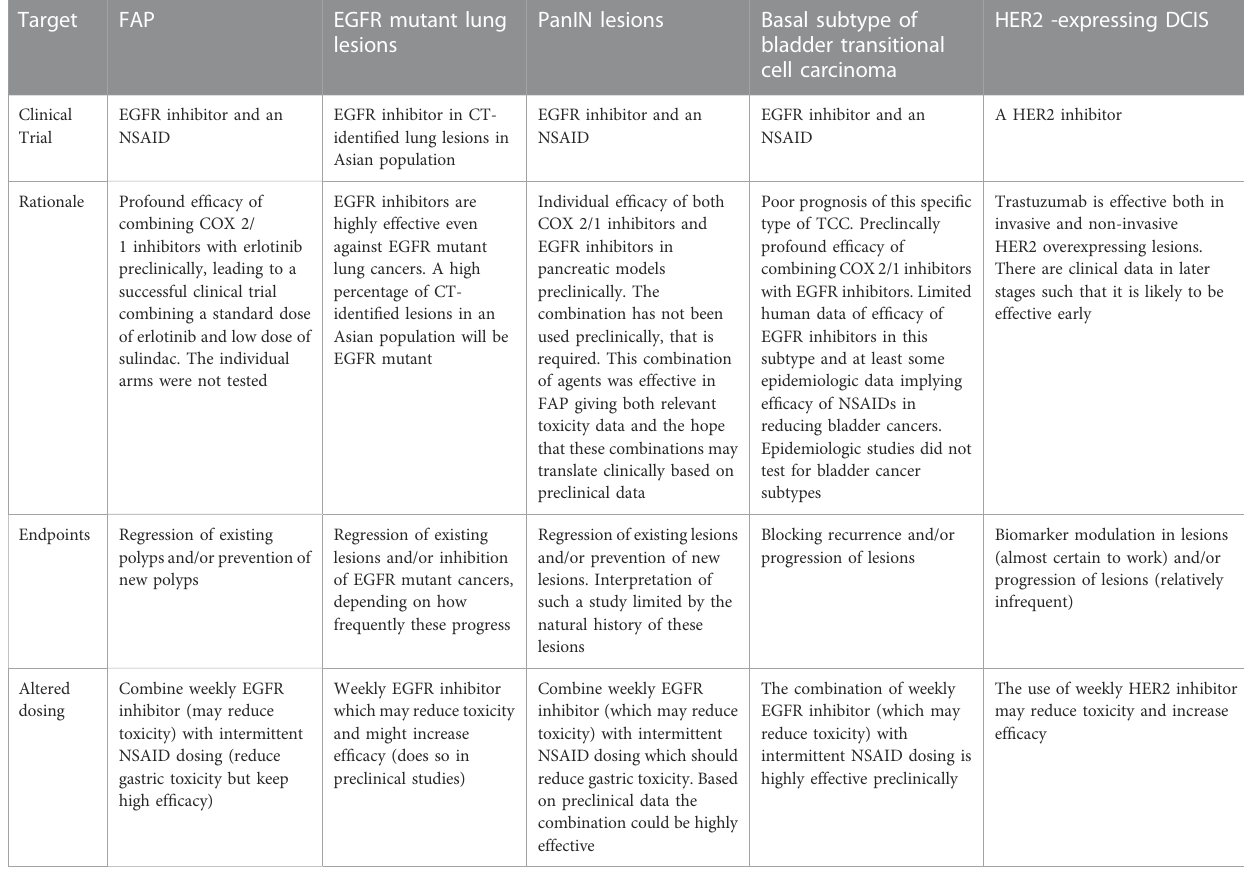
TABLE 2 Clinical interception trials which might be performed: the rationale for such trials, potential trial endpoints and altered dosing which might reduce toxicity and/or increase ef fi cacy (See also Figure 1).